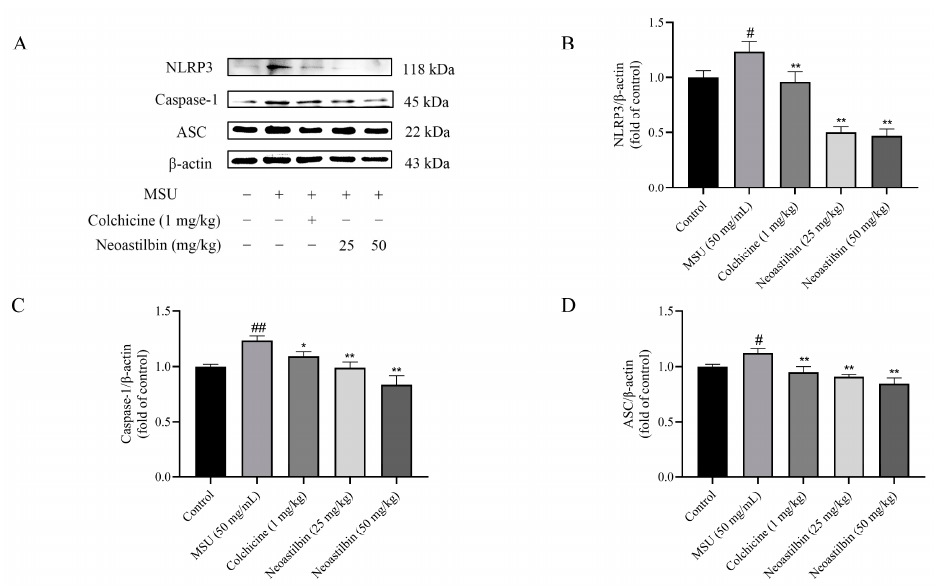
Figure 11. Effects of neoastilbin on protein expression of NLRP3 inflammasome in GA mice. ( A ) The protein expressions of NLRP3, Caspase-1 and ASC. ( B – D ) The ratio of protein expression of NLRP3, Caspase-1 and ASC. Data in the figures represent the means ± SD; significant differences among different groups are indicated as # p < 0.05, ## p < 0.01 vs. control group, * p < 0.05, ** p < 0.01 vs. MSU group ( n = 3).